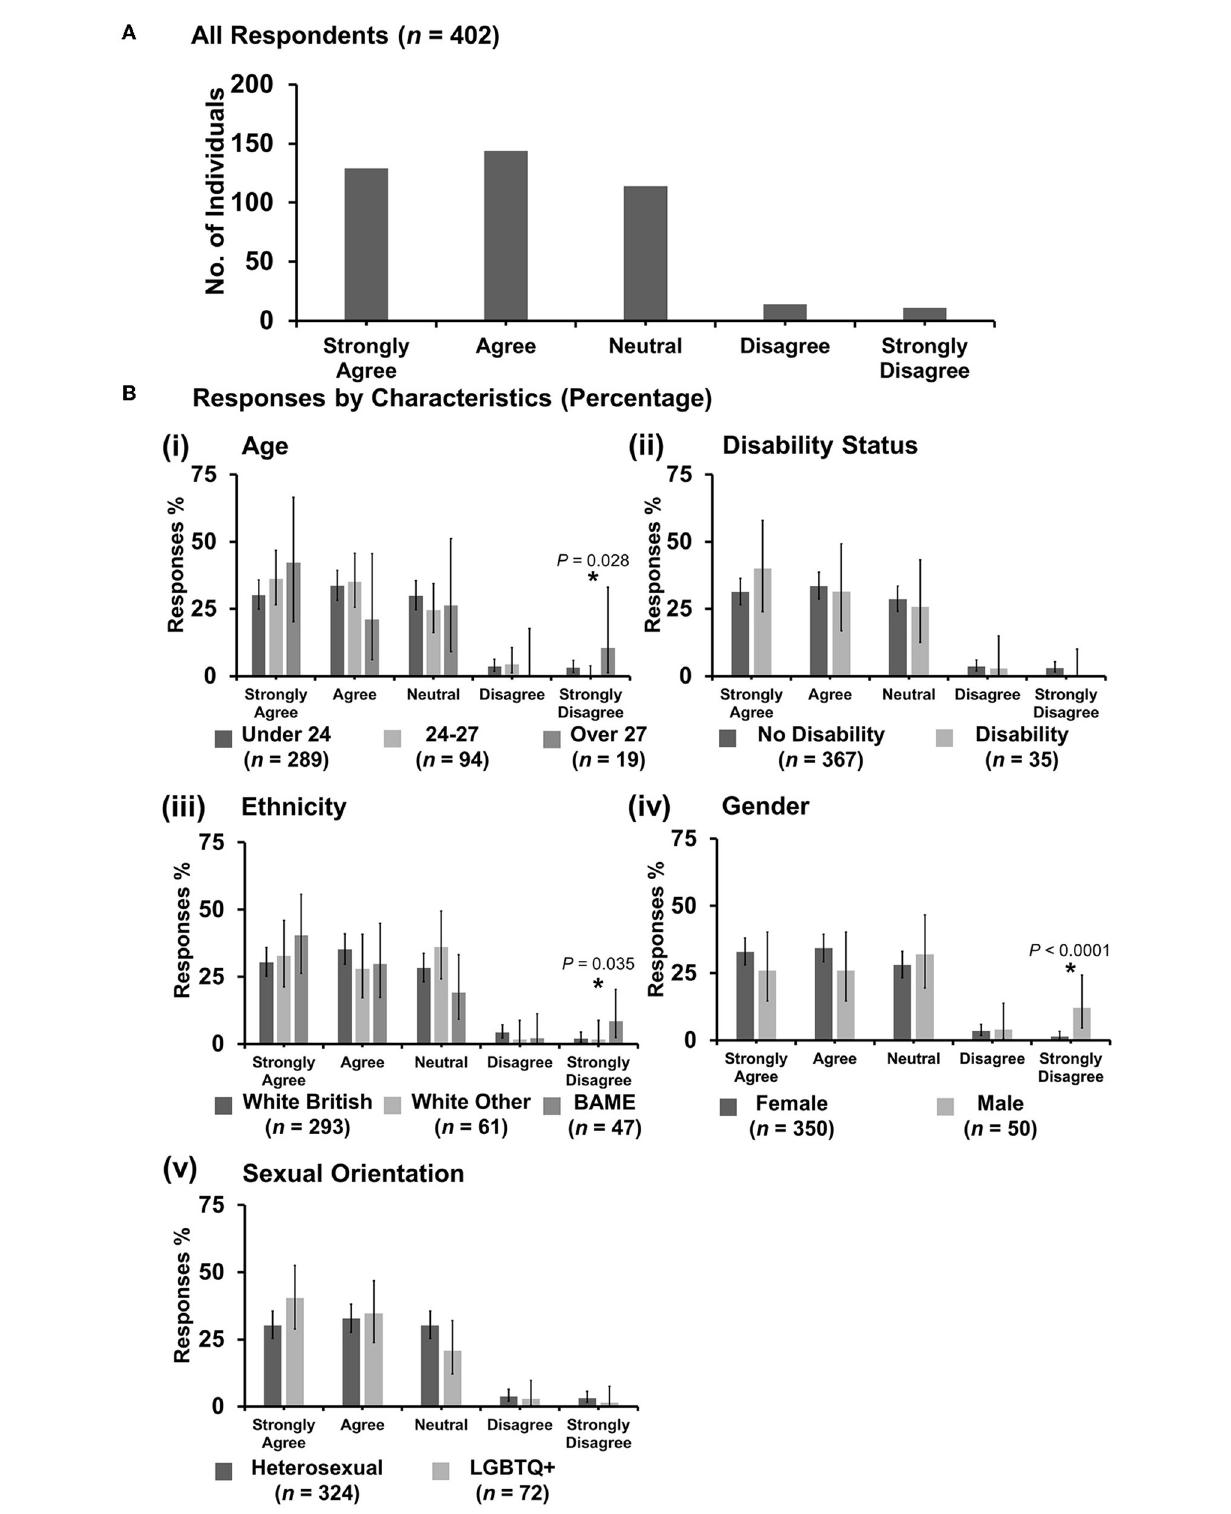
FIGURE11 Likert scale selections for the statement: the racial diversity in the veterinary profession needs to be increased. (A) Bar graph demonstrating the number of respondents selecting each Likert scale response. [ (B) i–v] Bar graphs demonstrating by percentage proportion the number of responses in each Likert category by the group under the demographic categories of age, disability status, ethnicity, gender, and sexual orientation. Error bars represent 95% confidence intervals calculated by the Binomial “Exact” method. Statistical significance was determined by Pearson’s chi-squared test of association between respondent’s group under category and Likert scale selection. * P <